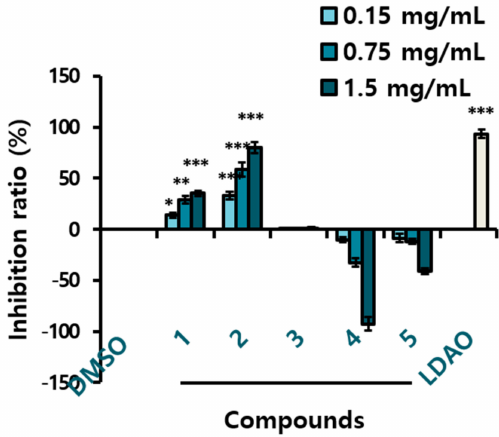
Figure 3. Growth inhibition ratio of yeast treated with the compounds 1 – 5 isolated from the AHC extract. The inhibition ratio was calculated by following equation: Inhibition ratio (%) = 100 − [(T − T 0 / N − N 0 ) × 100]; T: the OD of yeast solution after incubation; T 0 : the OD of yeast solution before incubation; N: the OD of negative control after incubation; N 0 : the OD of negative control before incubation; 0.1% DMSO in culture medium: negative control; LDAO of 688.2 µ g / mL: positive control; optical density (OD). Data of * p < 0.5, ** p < 0.05, and *** p < 0.005 vs.